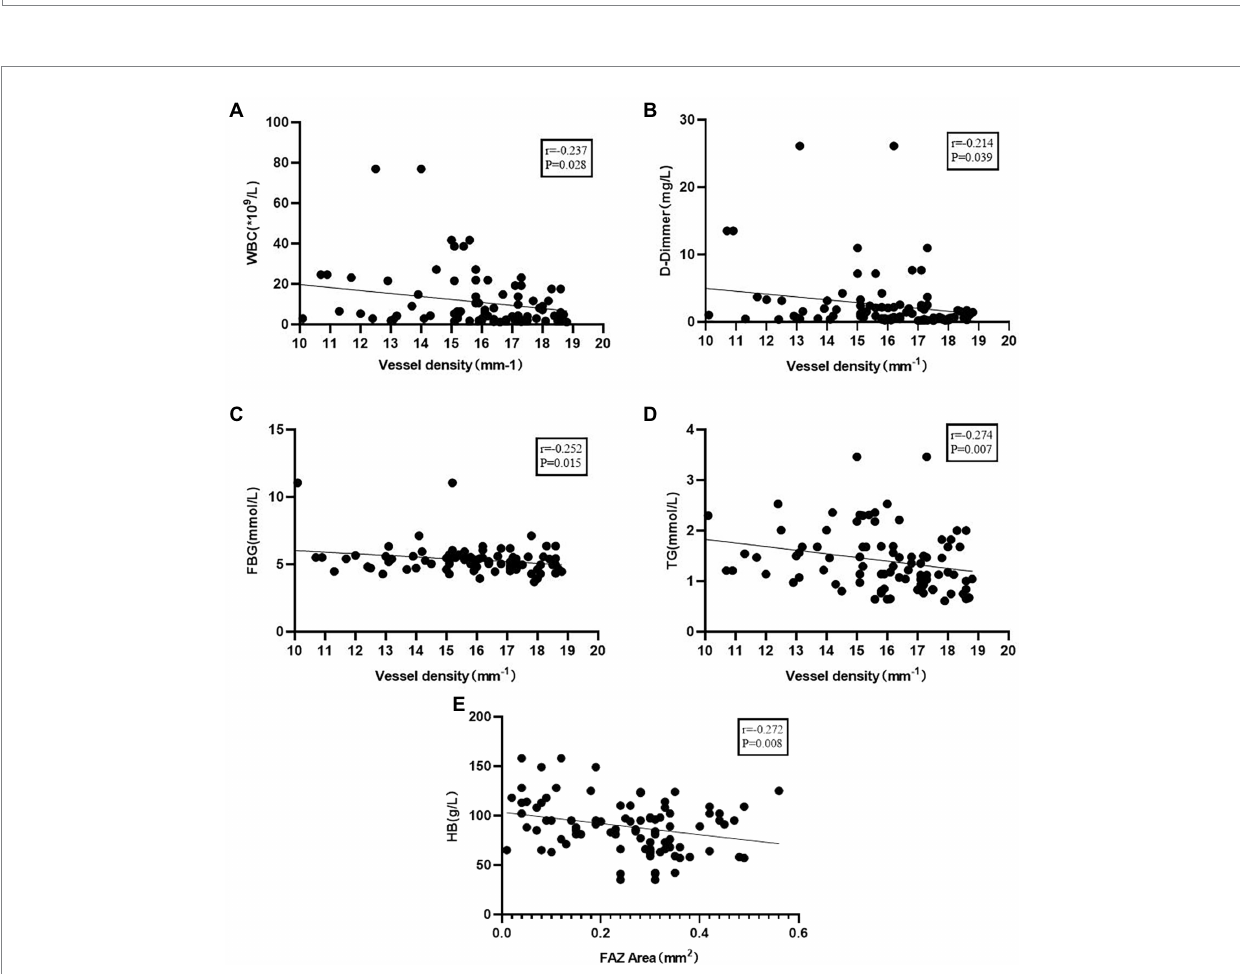
FIGURE 4 (A) Correlation of vessel density with white blood cells (WBC). (B) Correlation of vessel density with D-dimmer. (C) Correlation of vessel density with fasting plasma glucose (FBG). (D) Correlation of vessel density with triglyceride (TG). (E) Correlation of foveal avascular zone (FAZ) area with HB.